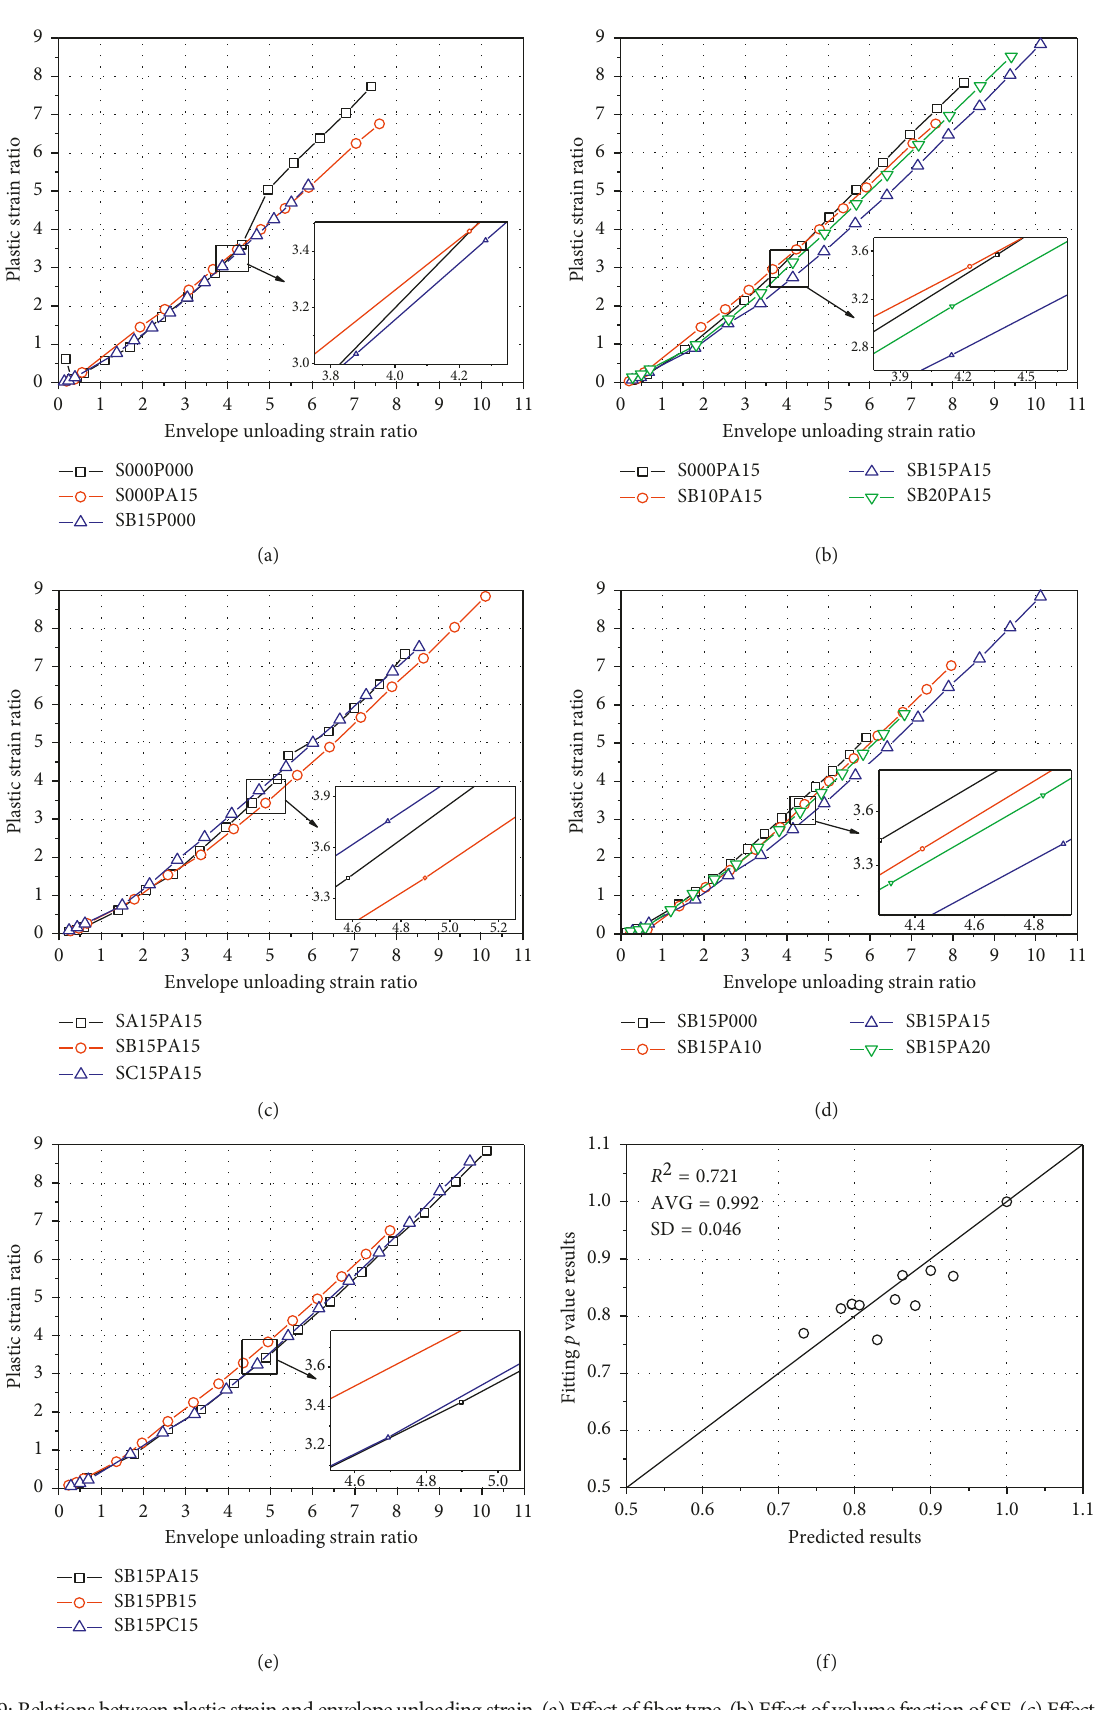
Figure 9: Relationsbetween plastic strain and envelopeunloading strain.(a) Effectof fiber type.(b) Effect of volume fractionof SF. (c) Effectof aspect ratio of SF. (d) Effect of volume fraction of PF. (e) Effect of aspect ratio of PF. (f) Comparisons of plastic strain between fitting and predicted